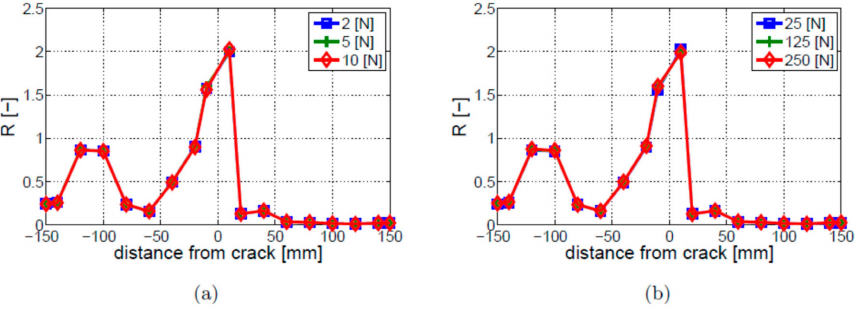
Figure 12. Parametric study of excitation amplitude for the breathing crack model and different amplitude levels of ( a ) ultrasonic HF excitation; ( b ) vibration LF